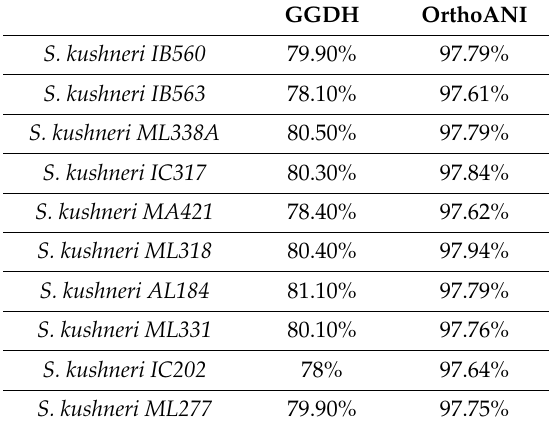
Table 1. In silico Genome-to-Genome Hybridization (GGDH), and OrhtoANI values of Salinivibrio sp. HTSP with 10 other strains of Salinivibrio kushneri isolated from the salterns in Spain [34]. GGDH